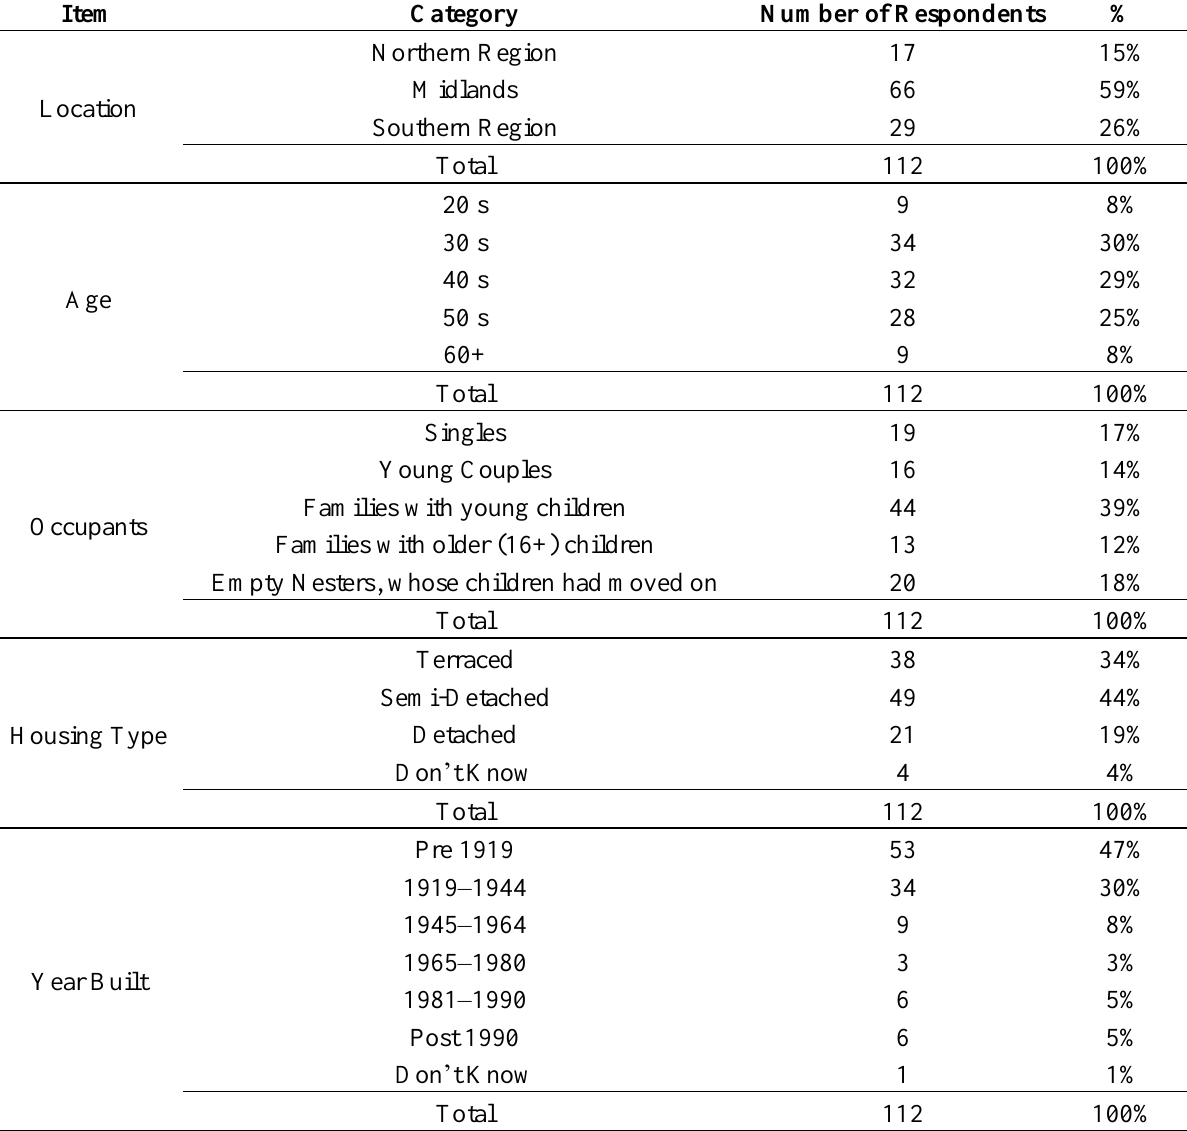
Table 2. Homeowners’ profile.